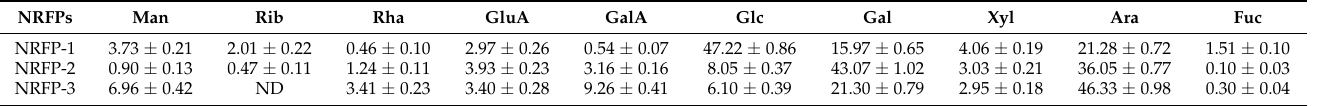
Table 5. Monosaccharide compositions of NRFPs